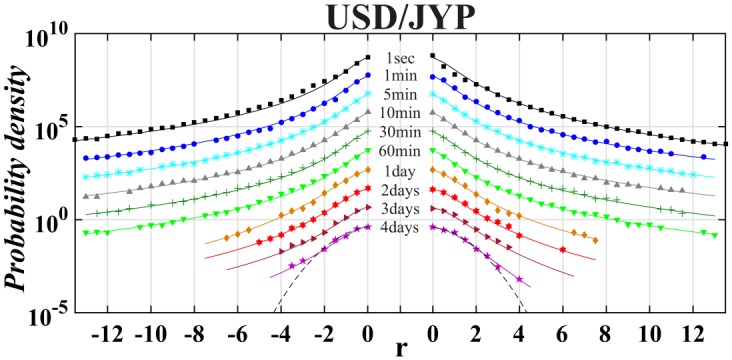
Same as in Fig 10 for USD/JYP exchange rate.